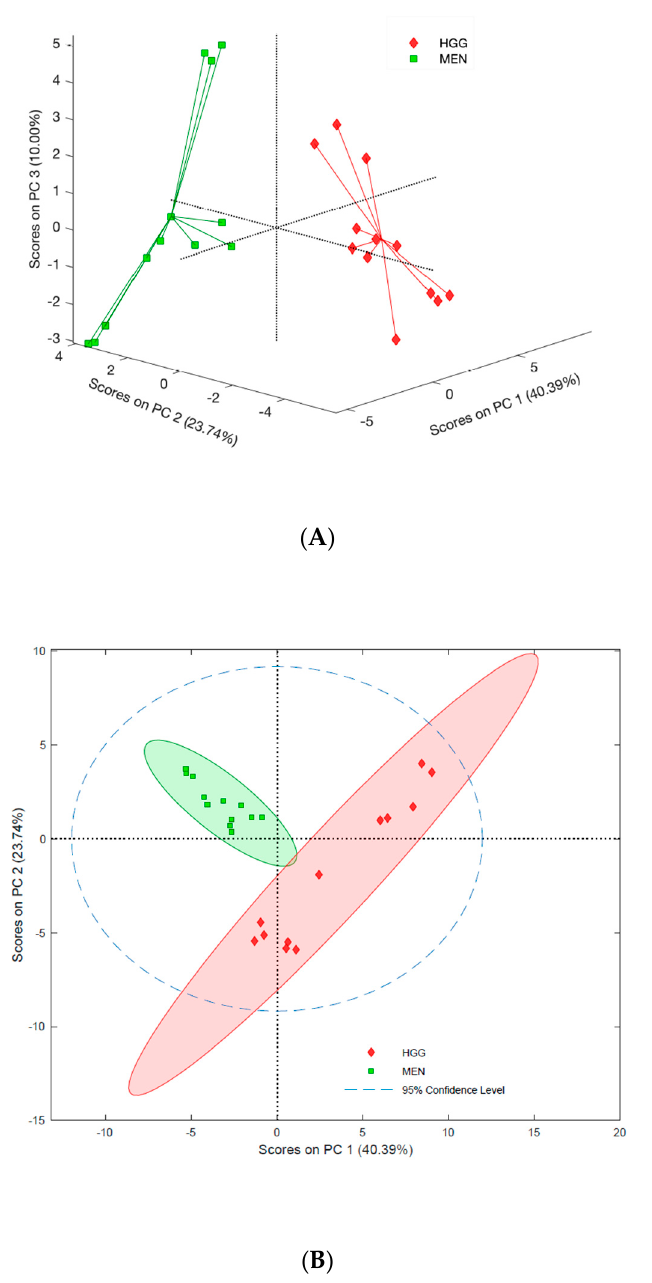
Figure 2. ( A ) Three-dimensional principal component analysis plot; preprocessing of variables: log10 and autoscale. ( B ) Two-dimensional principal component analysis plot showing samples from the same tumor; preprocessing of variables: log10 and autoscale. ( C ) Hierarchical clustering dendrogram based on tentative lipids with a VIP score above 1.0; preprocessing of variables: log10 and autoscale. Samples 36, 56, 59, and 75 were meningiomas, and samples 17, 39, 86, and 87 were gliomas. The number after the lower dash denotes the replicate inserted into the same lesion.